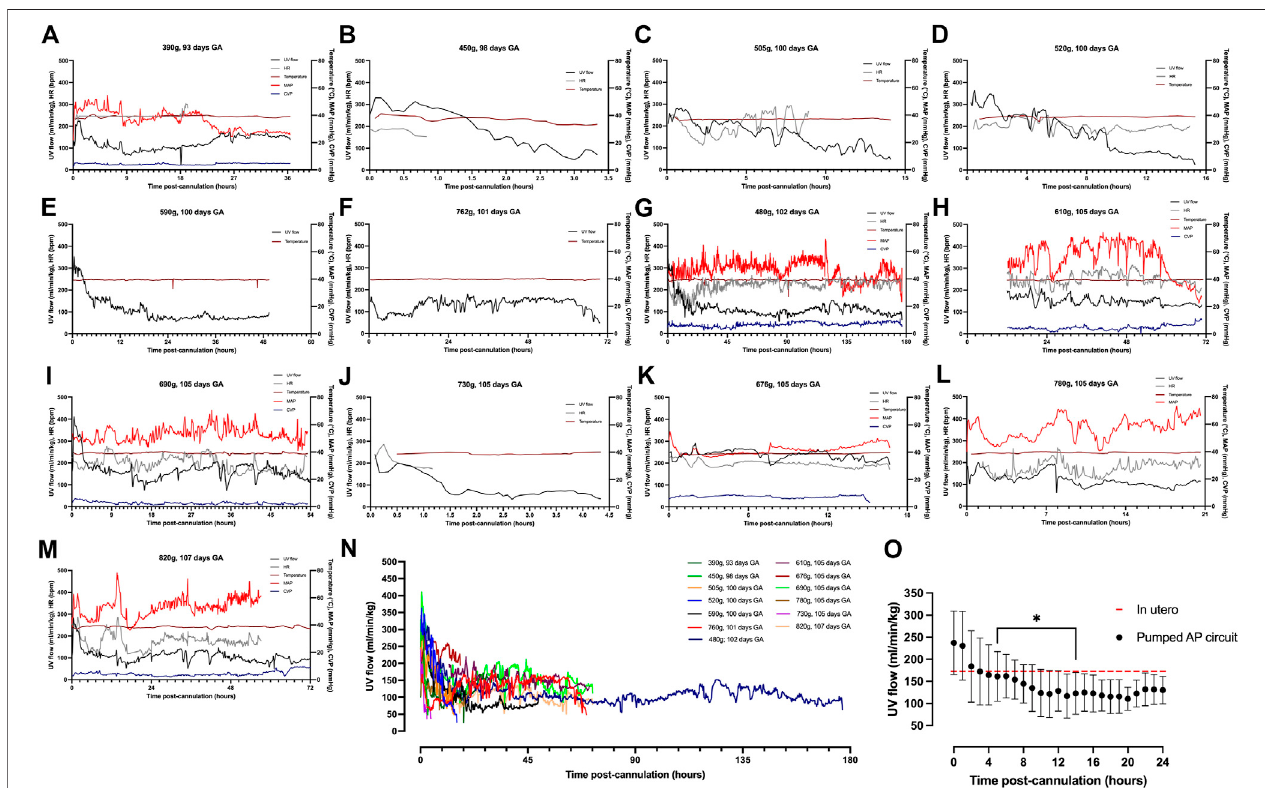
FIGURE 3 | Hemodynamic data in pumped AP fetal pigs. Data from n = 13 fetal pigs. (A – M) Changes in UV fl ow, HR, temperature, MAP, and CVP over time for each individualanimalsupported usingapumped APcircuit. (N) IndividualUV fl owpatternsforfetalpigs. (O) AggregateUV fl owdataforpumpedAPfetalpigs.Pumped AP fetal pigs are represented as black circles, and in utero UV fl ow as the dashed red line. Data are presented in 5-minute (A – N) and 1-hour epochs (O) . * Signi fi cantly different from the fi rst recorded data point.